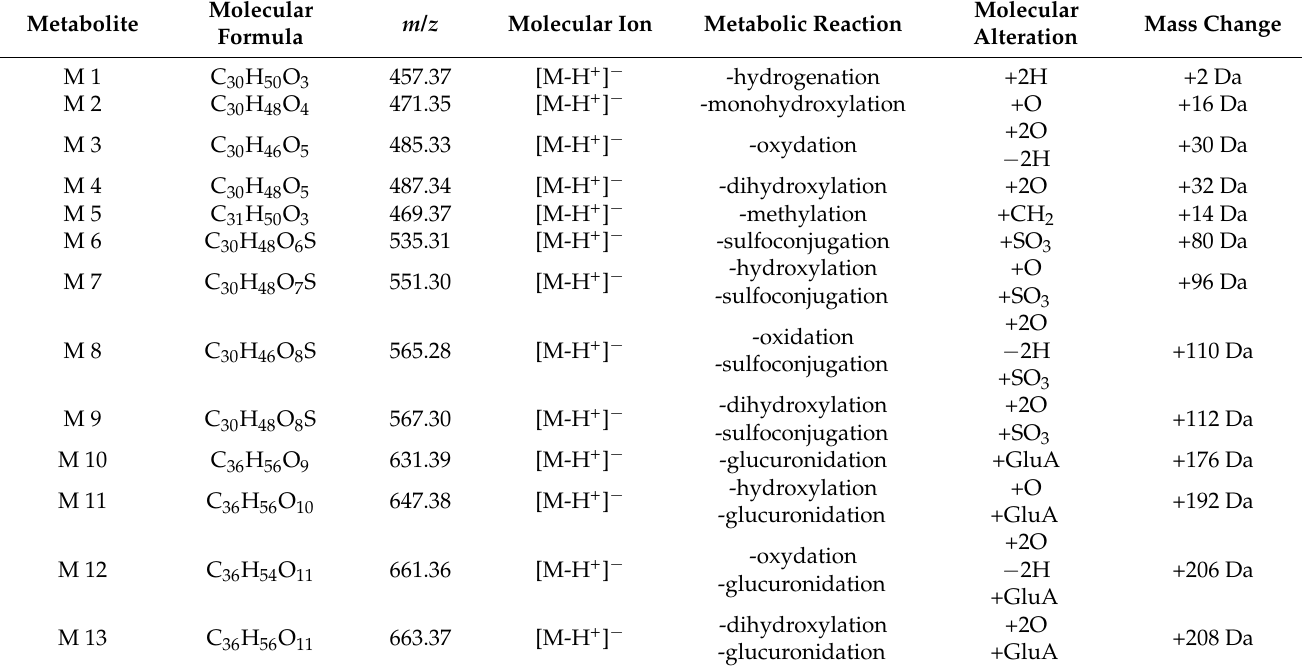
Table 1. Proposed phase I and phase II metabolic products of betulinic acid (BA) (3 β , hydroxy-lup- 20(29)-en-28-oic acid).